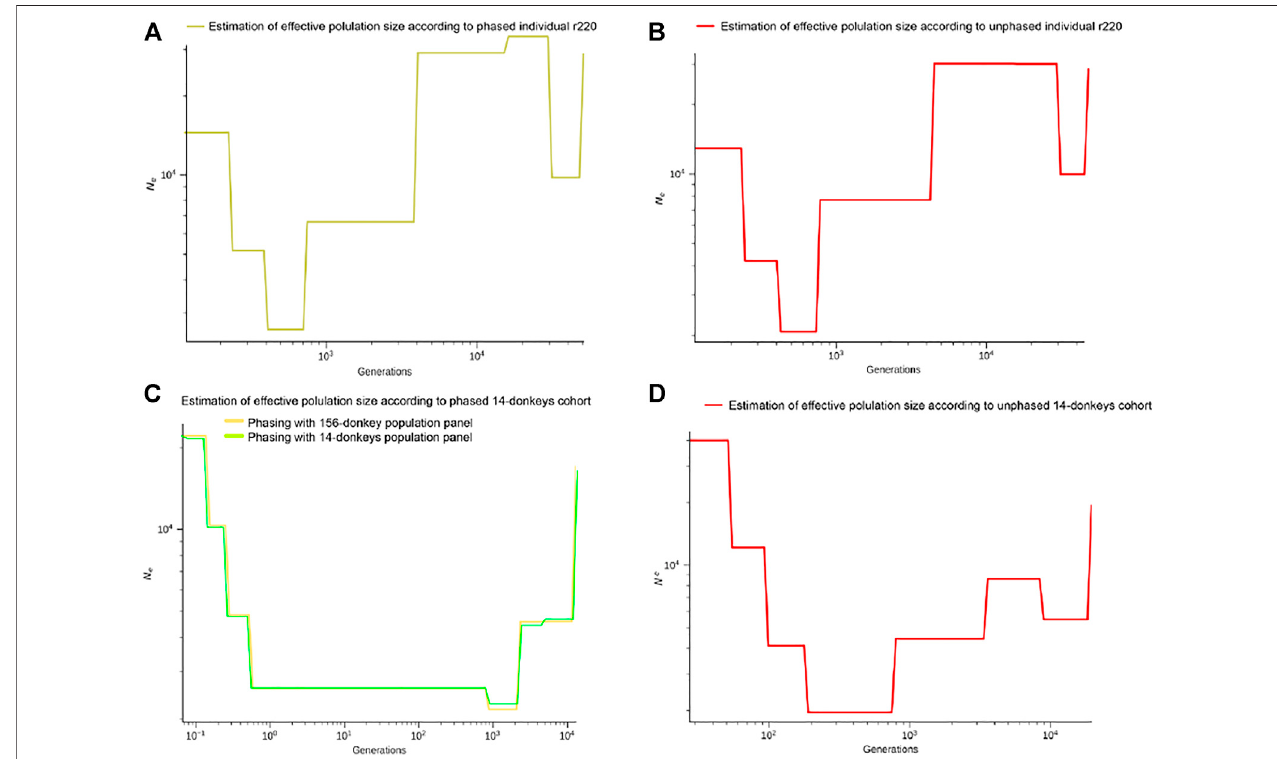
FIGURE 7 | The dots indicated the admixture events on the SMC++ effective population size curves, (A) for phased individual donkeys (r220), (B) for un-phased individual donkeys, (C) for phased 14-donkeys cohort with 14/156-donkeys cohort, (D) for un-phased 14-donkeys